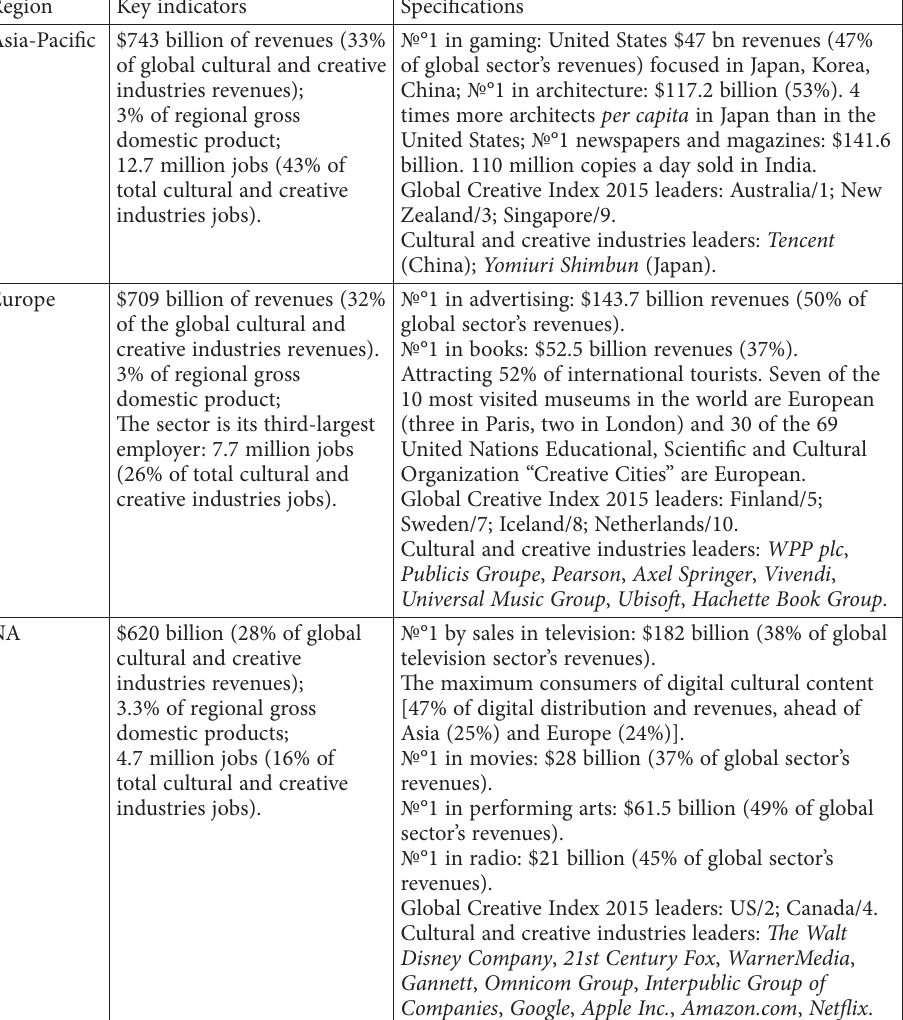
Table 1. Characteristics of the development of cultural and creatives in the regions of the world mar- ket leaders (source: created by authors (based on ey.com, 2015)) Region Key